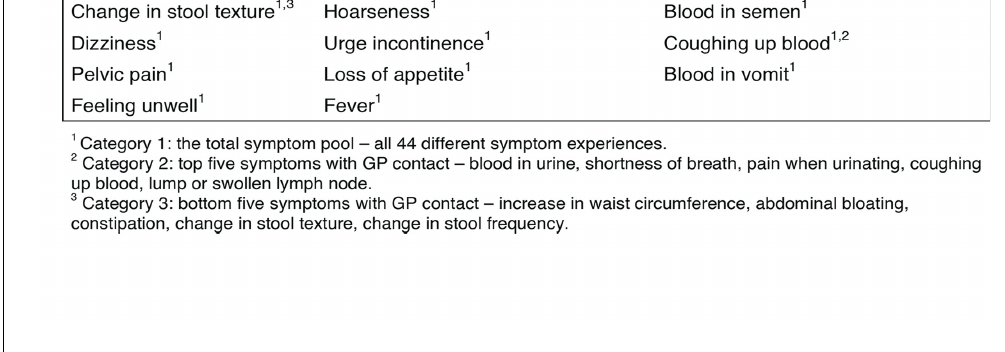
Figure 2. The 44 predefined symptoms from the